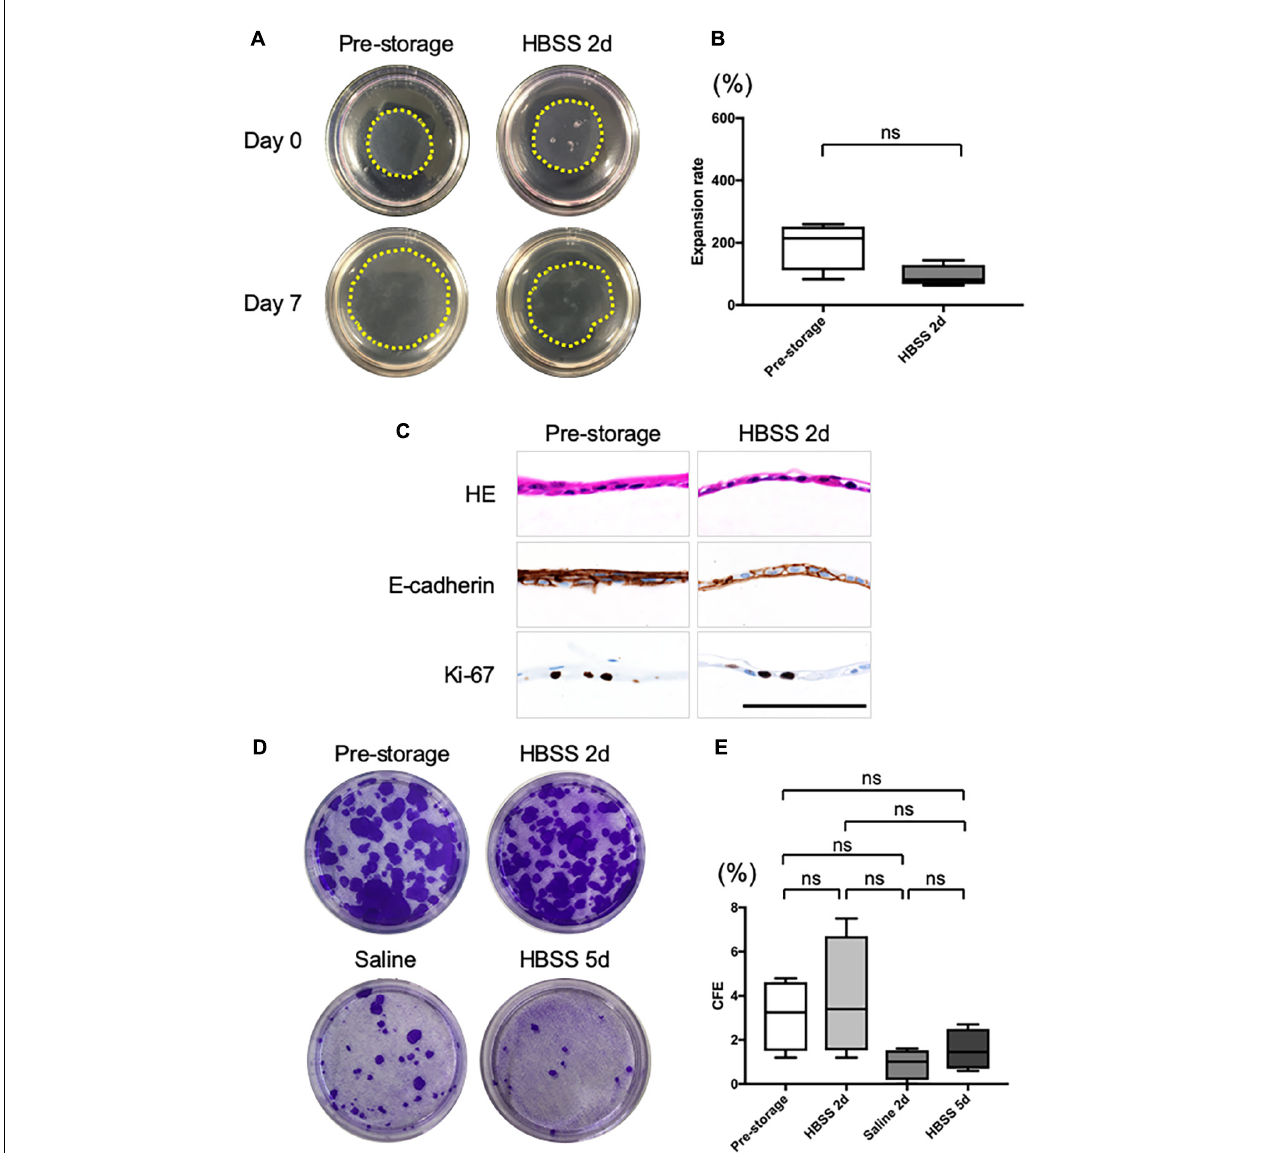
FIGURE 3 | In vitro evaluation of the cell sheet after grafting. (A) Representative images of pre- and post-storage cell sheets, 0 and 7 days after grafting on type I collagen gels in 60 mm dishes. The yellow dotted line shows the edge of grafted cell sheets. (B) Expansion rate of cell sheet size from day 0 to day 7 after grafting ( n = 6). (C) Hematoxylin and eosin (HE) staining and immunohistological evaluation of the expression of E-cadherin and Ki-67 in cell sheet 7 days after grafting on collagen gel. (D) Representative images of colony-forming assays for pre- and post-storage cell sheets under each condition. (E) Colony-forming efficiency (CFE). Values are expressed as the mean ± SEM ( n = 6) values. ns, not